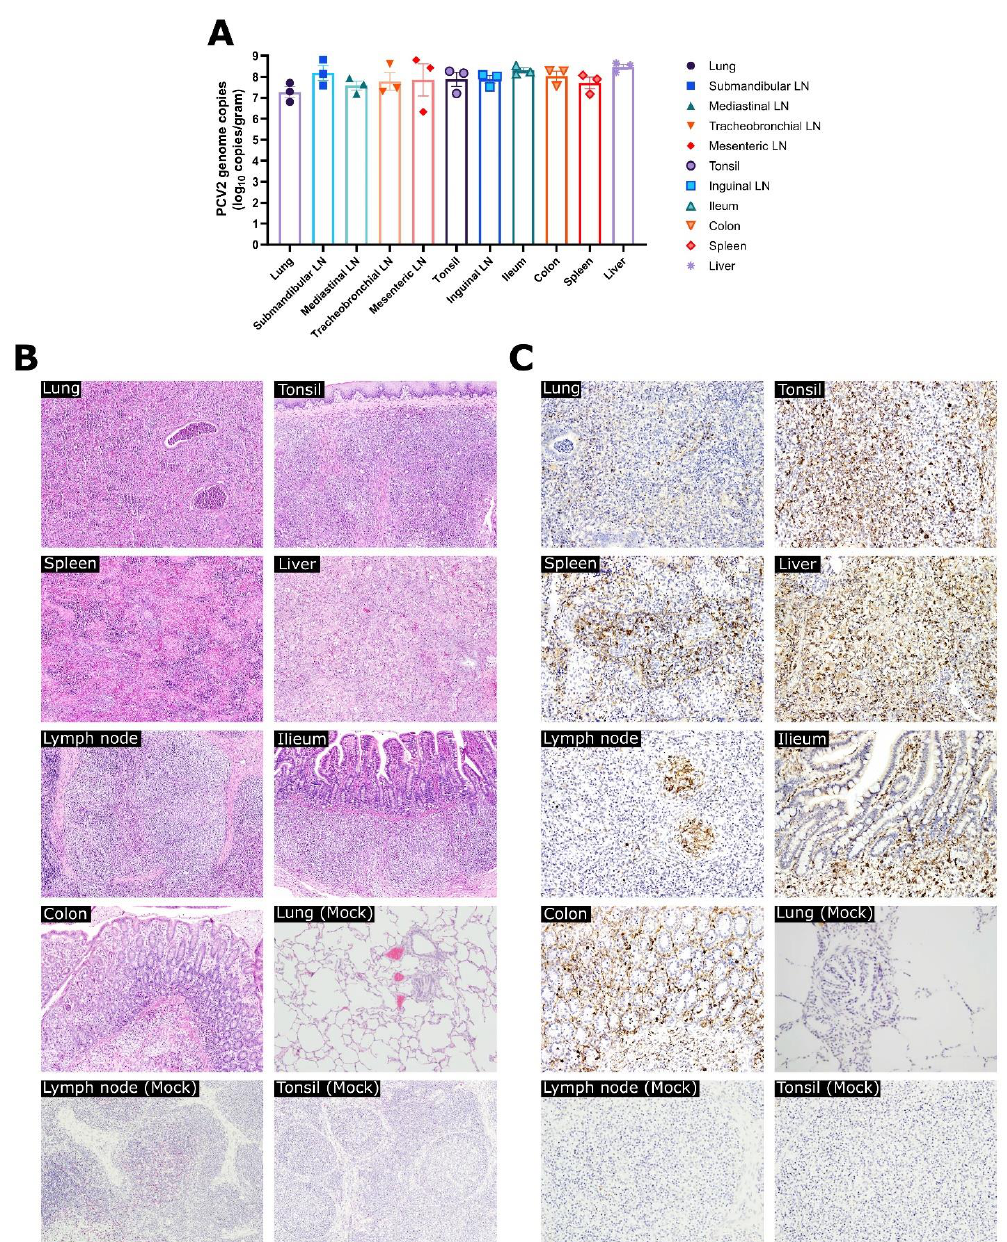
Figure 4. PCV2 genome copies, histological and immunohistochemical findings from PCV2d infection group in the experimental infection/pathogenicity study (Experiment 1). The levels of PCV2 genome copies in multiple organs obtained from the PCV2d infection group ( A ), and representative images of histological findings by H&E staining (( B ), magnification: ×100) or immunohistochemistry staining (( C ), magnification: ×200) within tissue samples obtained from the PCV2d infection group. The data of PCV2 genome copies are presented as group means ± SEM. Immunolabeling of PCV2 was observed as a dark brown signal.